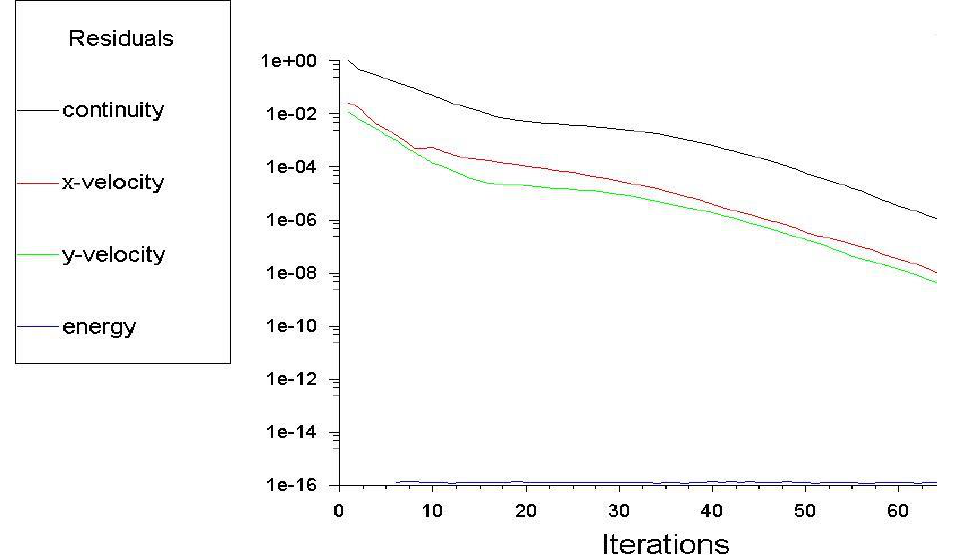
Figure 3. Convergence criteria of DIPTR.